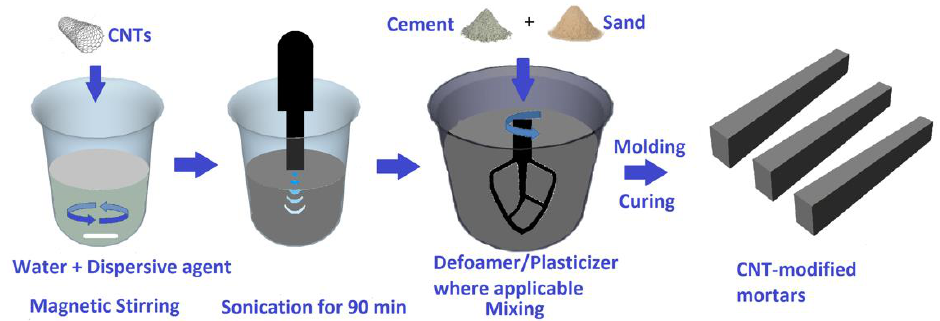
Figure 1. Schematic illustration of the specimen’s preparation